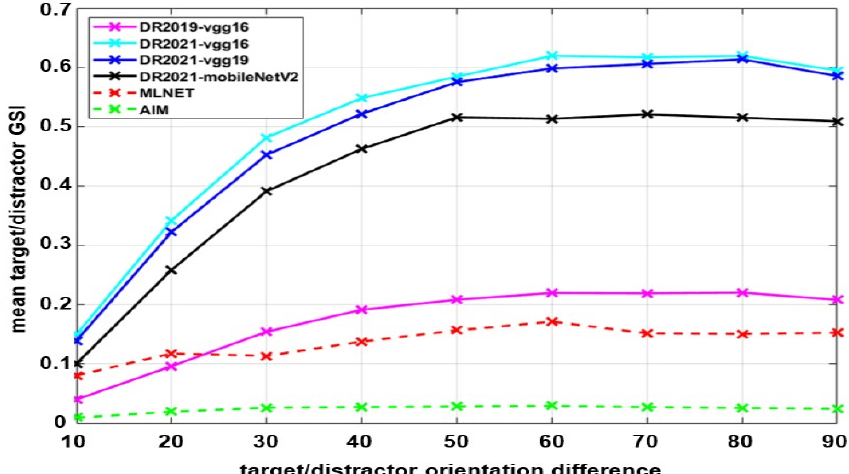
Figure 13. The GSI score for the orientation target/distractor difference. Best classical (green dotted line) and deep learning (red dotted line) along with the DeepRare family